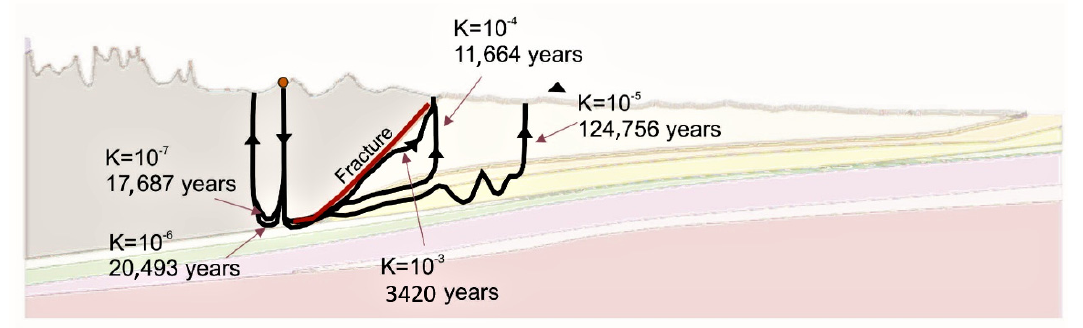
Figure 16. Sensitivity analysis of the conductive fault.